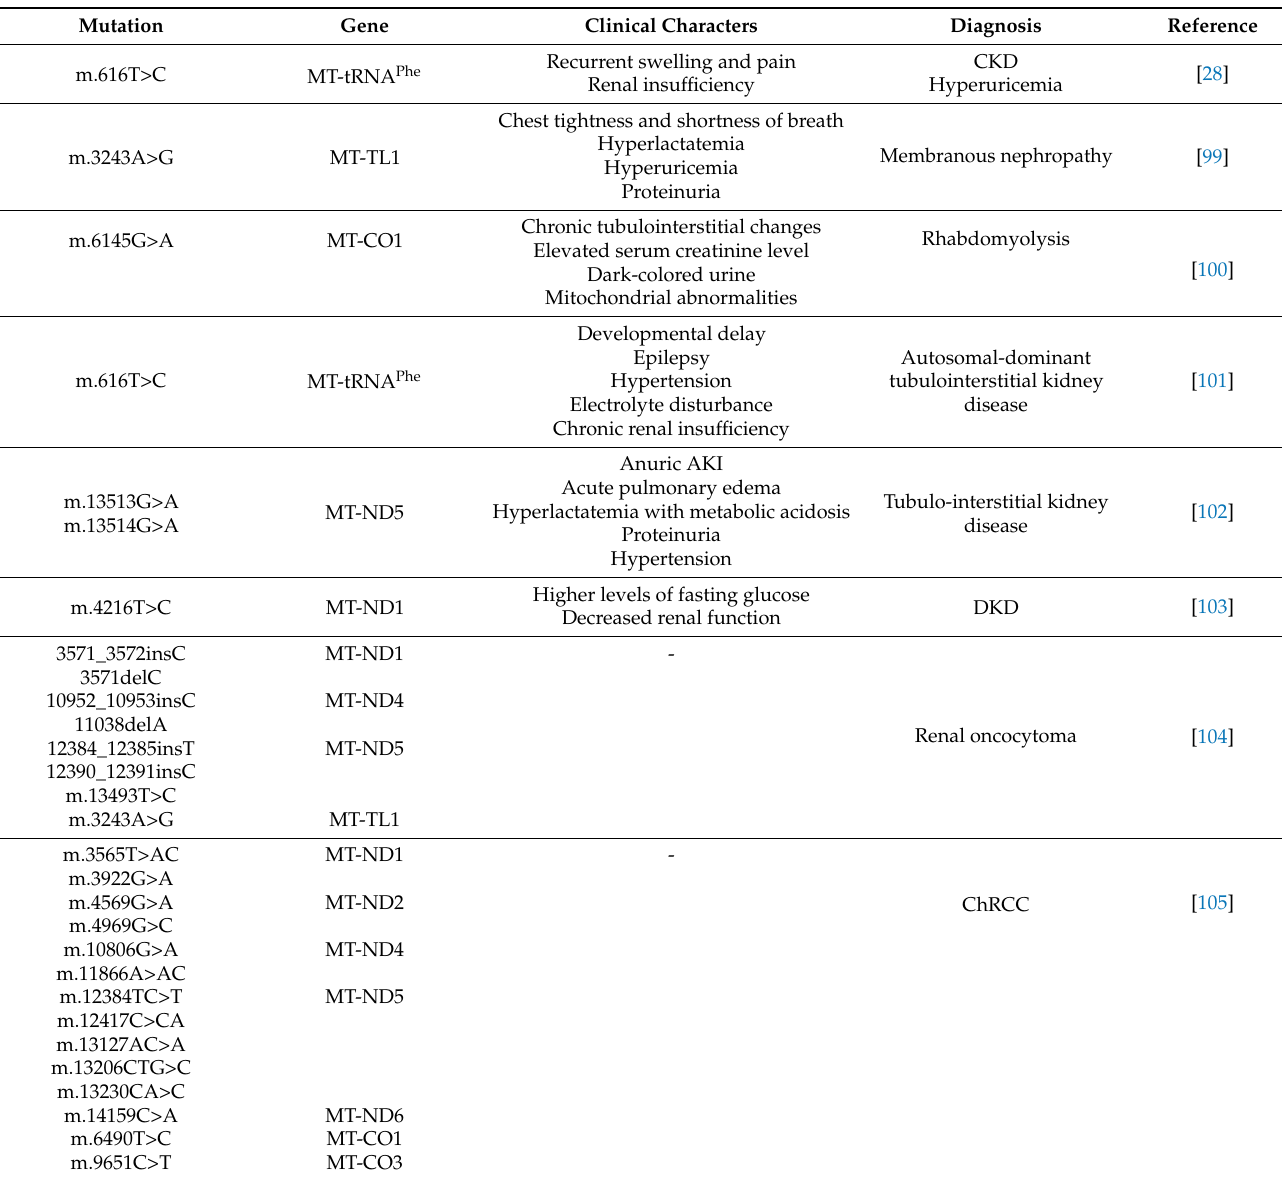
Table 1. mtDNA mutations in kidney